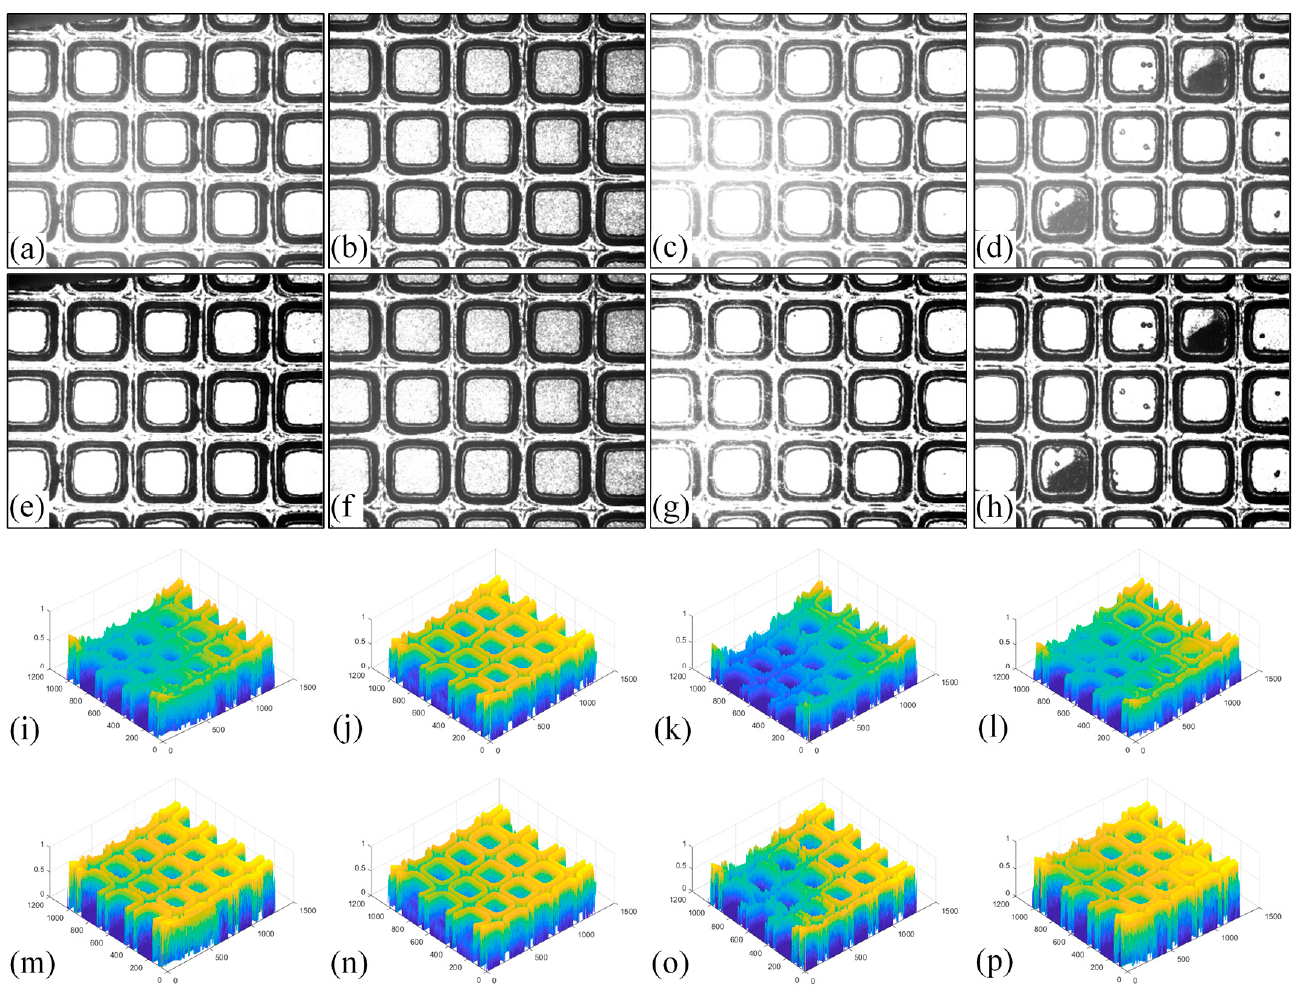
Figure 10. Comparison of brightness calibration for four categories of wafer images. ( a ) The wafer image of Cat.1_7; ( b ) the wafer image of Cat.3_7; ( c ) the wafer image of Cat.2_7; ( d ) the wafer image of Cat.4_1; ( e ) the result of brightness calibration on ( a ); ( f ) the result of brightness calibration on ( b ); ( g ) the result of brightness calibration on ( c ); ( h ) the result of brightness calibration on ( d ); ( i ) the grayscale distribution map of ( a ); ( j ) the grayscale distribution map of ( b ); ( k ) the grayscale distribution map of ( c ); ( l ) the grayscale distribution map of ( d ); ( m ) the grayscale distribution map of ( e ); ( n ) the grayscale distribution map of ( f ); ( o ) the grayscale distribution map of ( g ); ( p ) the grayscale distribution map of ( h ). Table 4. The quality evaluation results of NQ and BQ before and after the brightness calibration for four categories of wafer images.